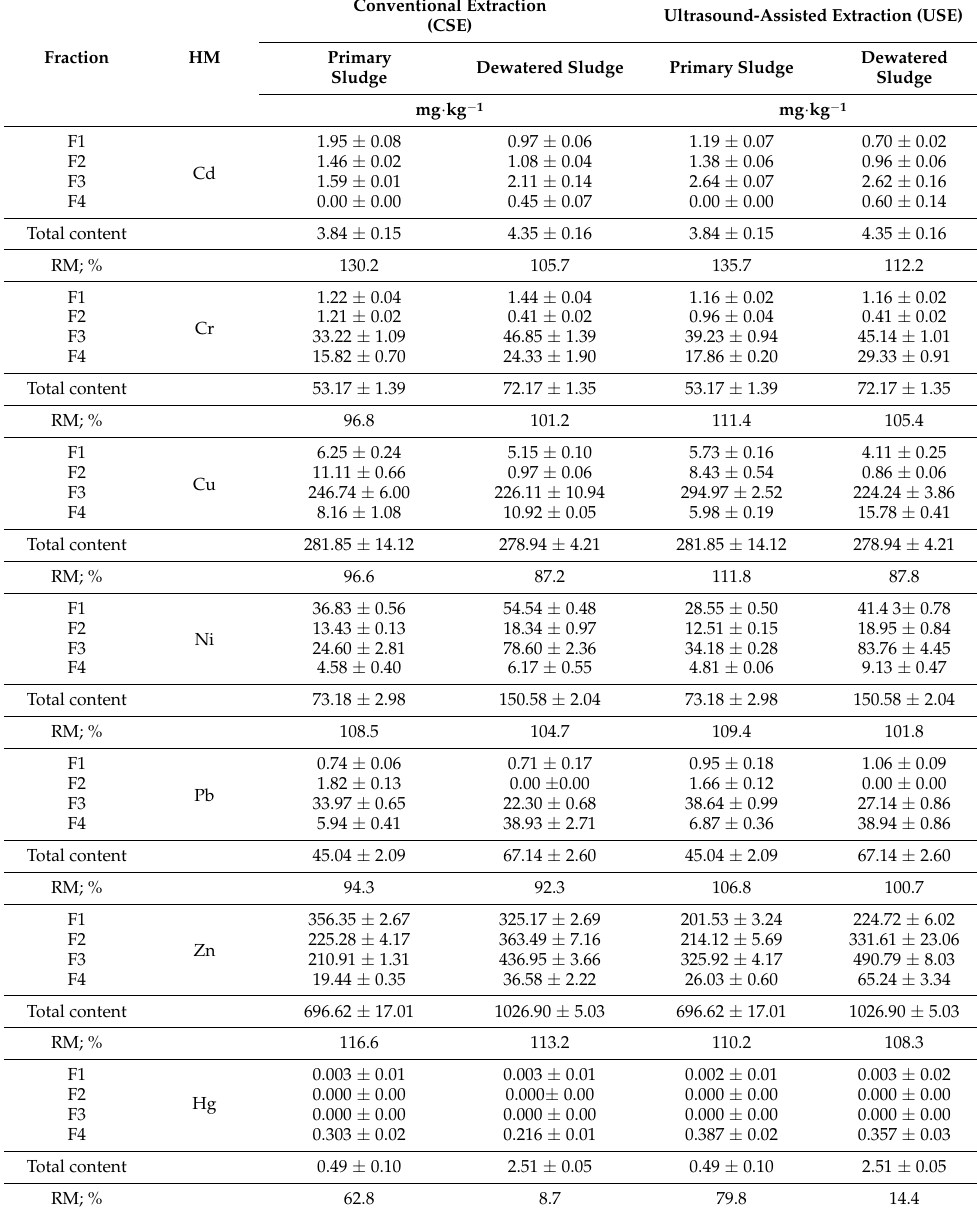
Table 6. Comparison of the results obtained by the conventional and ultrasound-assisted sequential extraction methods based on the heavy metal content in the primary and dewatered sludge. Conventional Extraction (CSE) Ultrasound-Assisted Extraction (USE) Fraction HM Primary